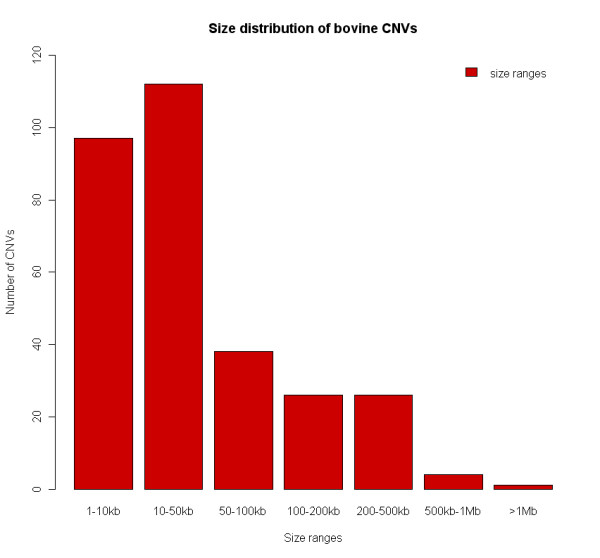
Size range distribution of the CNVRs detected.